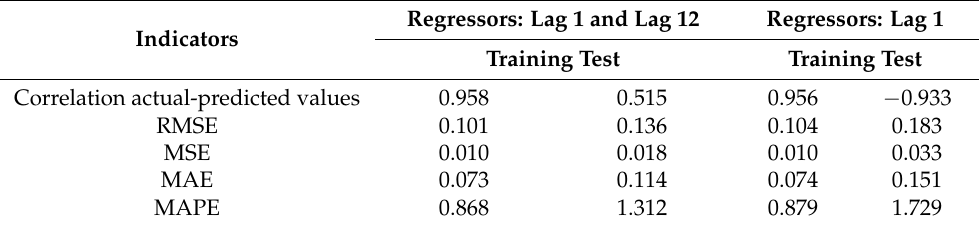
Table 5. The goodness of fit indicators for the best models built for U1_m.